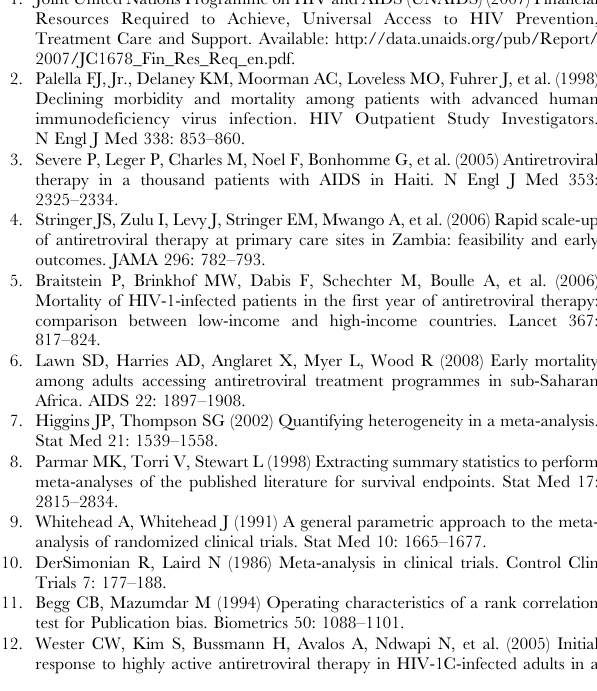
Table S4 Qualitative assessment of included studies. 1 Ascertainment bias was calculated from two parameters, a) Loss to follow–up mentioned and b) Active method for ascertainment